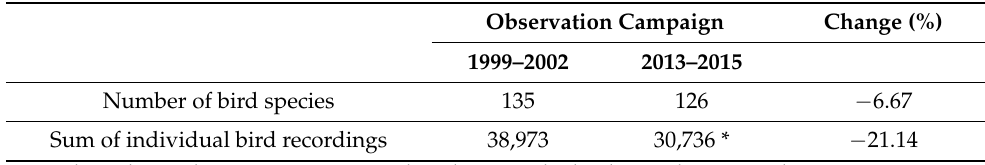
Table 3. Change in numbers of bird species and abundance over the entire